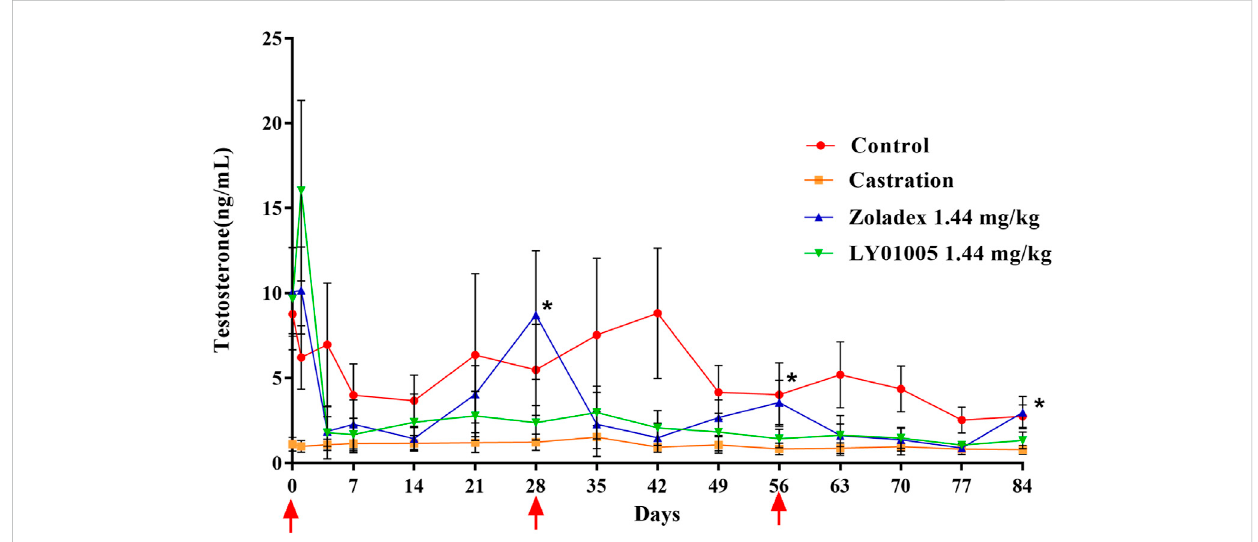
FIGURE 2 Effects of LY01005 on serum testosterone levels in male rats. *, p < 0.05 , LY01005 compared to Zoladex ® at the same dose.